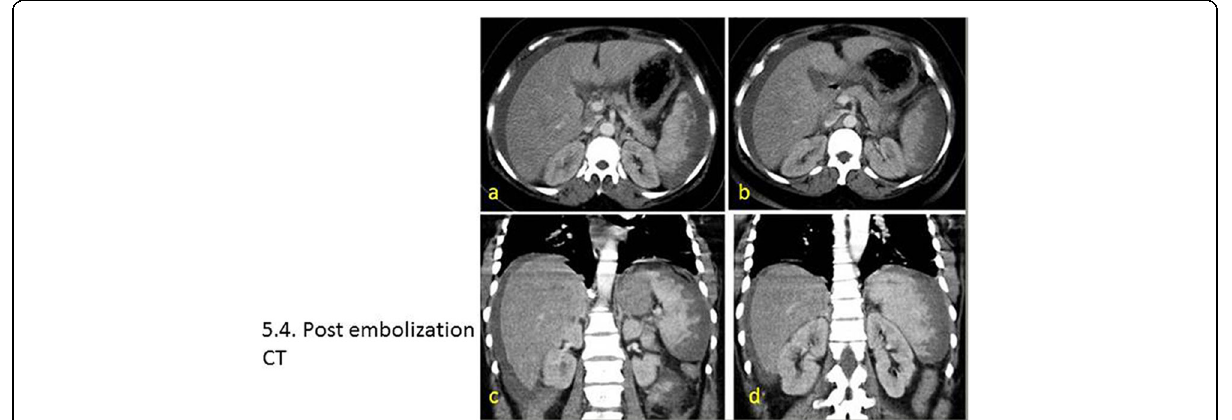
Fig. 13 Multislice CT study of the abdomen at the post-contrast phase. a , b Axial images. c , d Coronal reformatted images showing